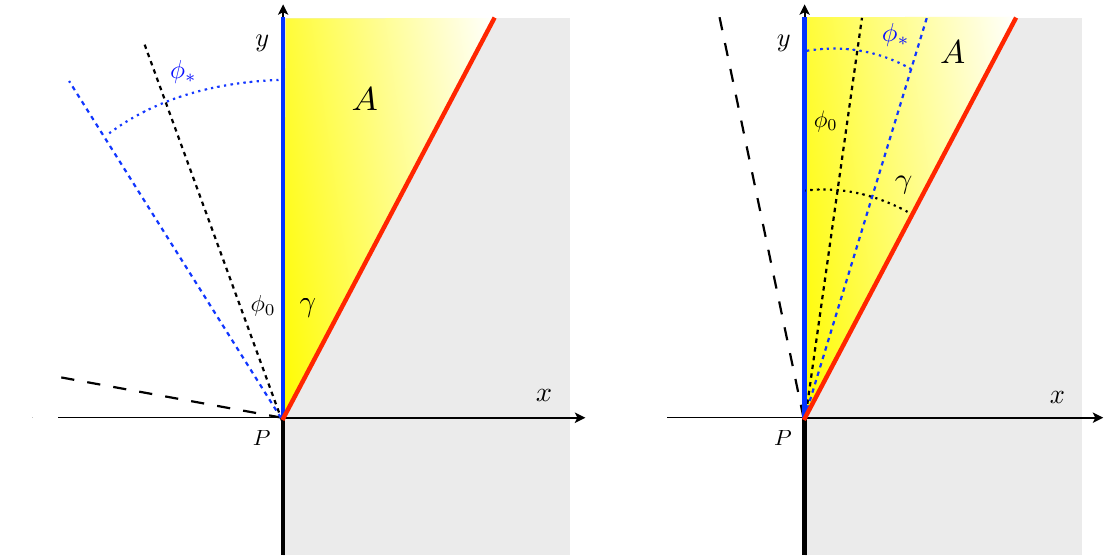
Figure 26 . The opening angles occurring in the construction of the minimal surface ^ (cid:13) A anchored to the in(cid:12)nite wedge A adjacent to the boundary with opening angle (cid:13) , which has been discussed in section 6 and in the appendix F. In the left panel (cid:11) 2 (0 ; (cid:25)= 2] and in the right panel (cid:11) 2 [ (cid:25)= 2 ; (cid:25) ). The wedge A is the yellow region, whose edges are the red and the blue solid half lines, given by (cid:30) = (cid:13) and (cid:30) = 0 respectively. The auxiliary wedge A is the in(cid:12)nite wedge in R 2 containing A aux whose tip is P and whose edges are the red half line and the black dashed line with the largest dashing. The black dashed line with the smallest dashing at (cid:30) = (cid:30) 0 corresponds to the bisector of A . The blue dashed half line at (cid:30) = (cid:30) (cid:3) corresponds to the projection of ^ (cid:13) A \Q in the z = 0 aux